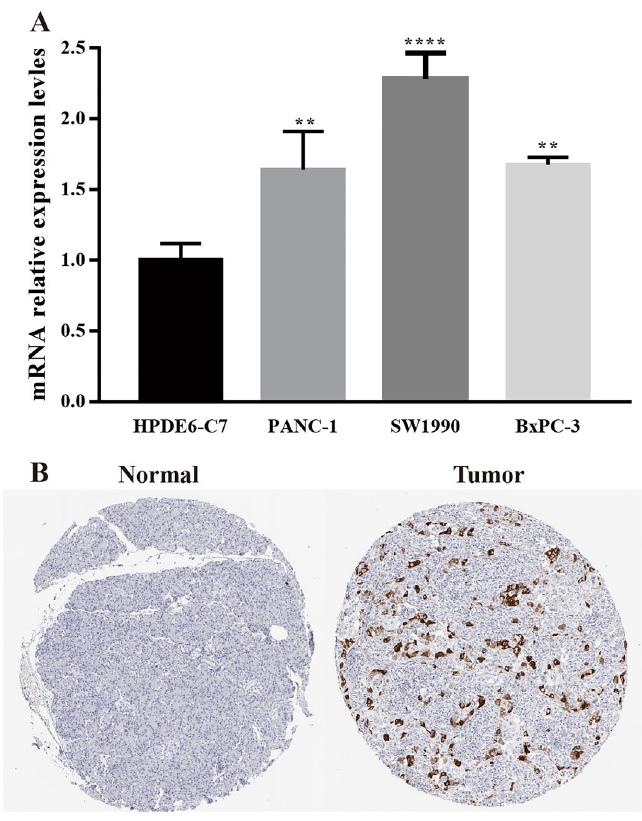
Figure 8. Expression validation of CCNB1 at mRNA and protein level. ( A ) Relative mRNA expression of CCNB1 in PANC-1, SW1990 and BxPC-3 compared with HPDE6-C7 cells. ( B ) The IHC staining of CCNB1 in normal and tumor tissues from HPA database was displayed. The antibody information is CCNB1 (CAB003804). * indicates P < 0.05, ** indicates P < 0.01, *** indicates P < 0.001, **** < indicates P < 0.0001.